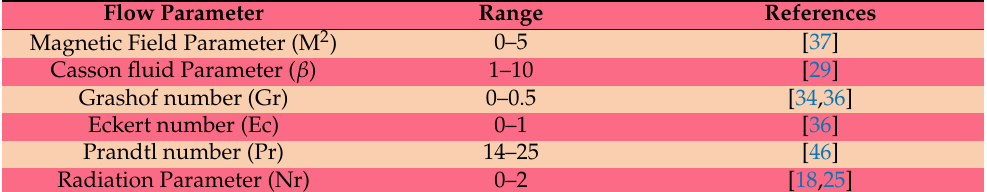
Table 6. Range of influential flow